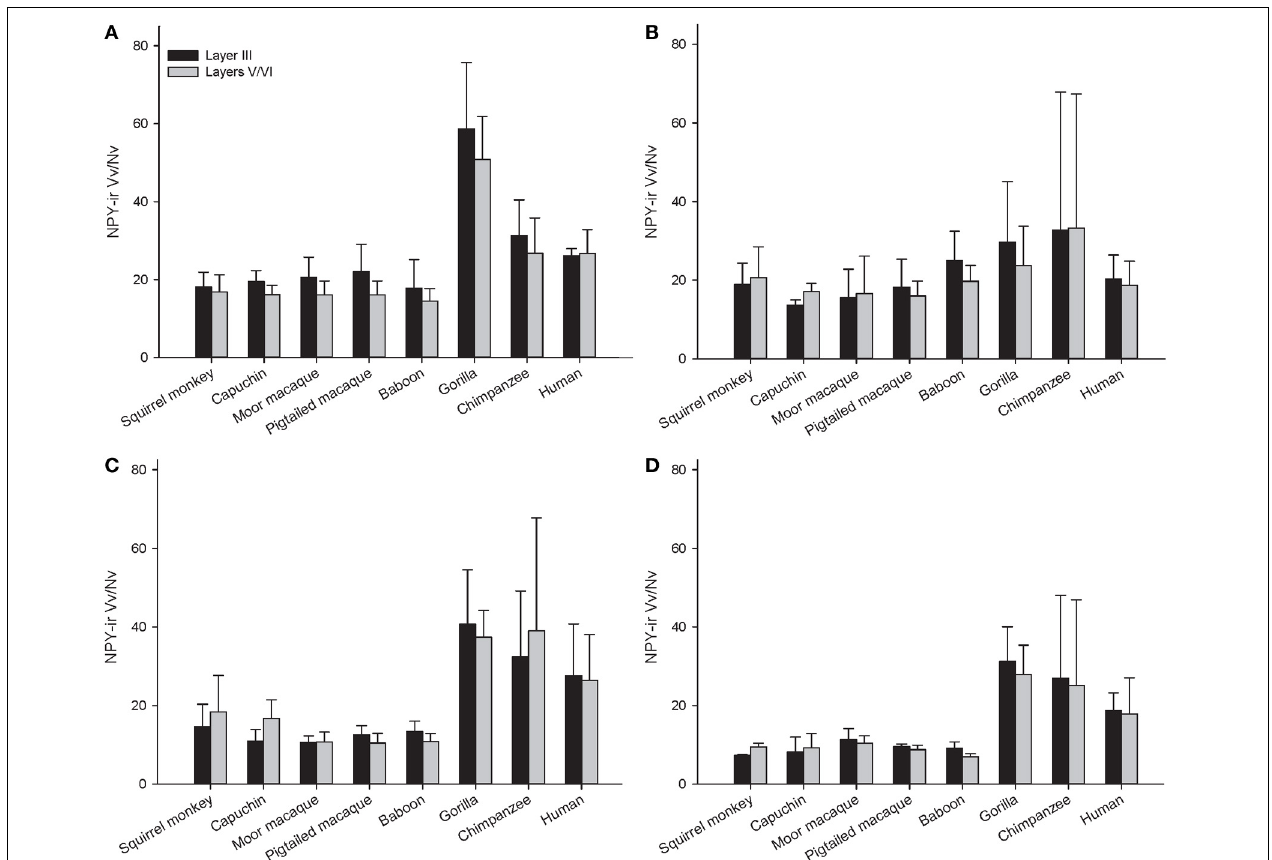
FIGURE 6 | NPY-irVv/Nv for each species in (A) area 10, (B) area 24, (C) area 44, and (D) area 22. Means are shown by bars. Error bars indicate standard